Question: Give a one-sentence summary of this figure.
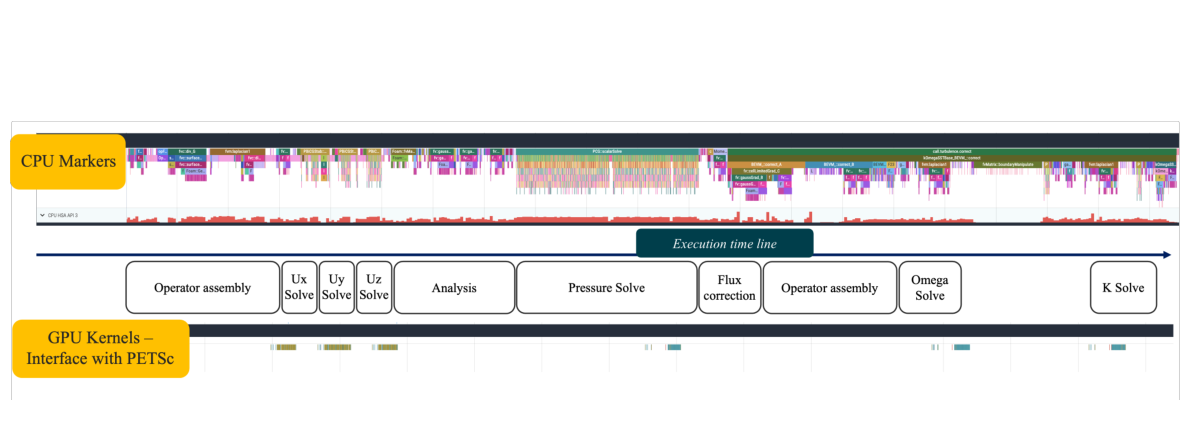
Answer: Markers for the CPU-execution (top half) and trace of the GPU kernels offloaded (bottom-half) with PETSc interface show the execution of the HPC motorbike benchmark (Large with 34 M cells) with simpleFoam solver for a single time step ti. Identifiers for the different stages of computations are marked in the Execution time line.